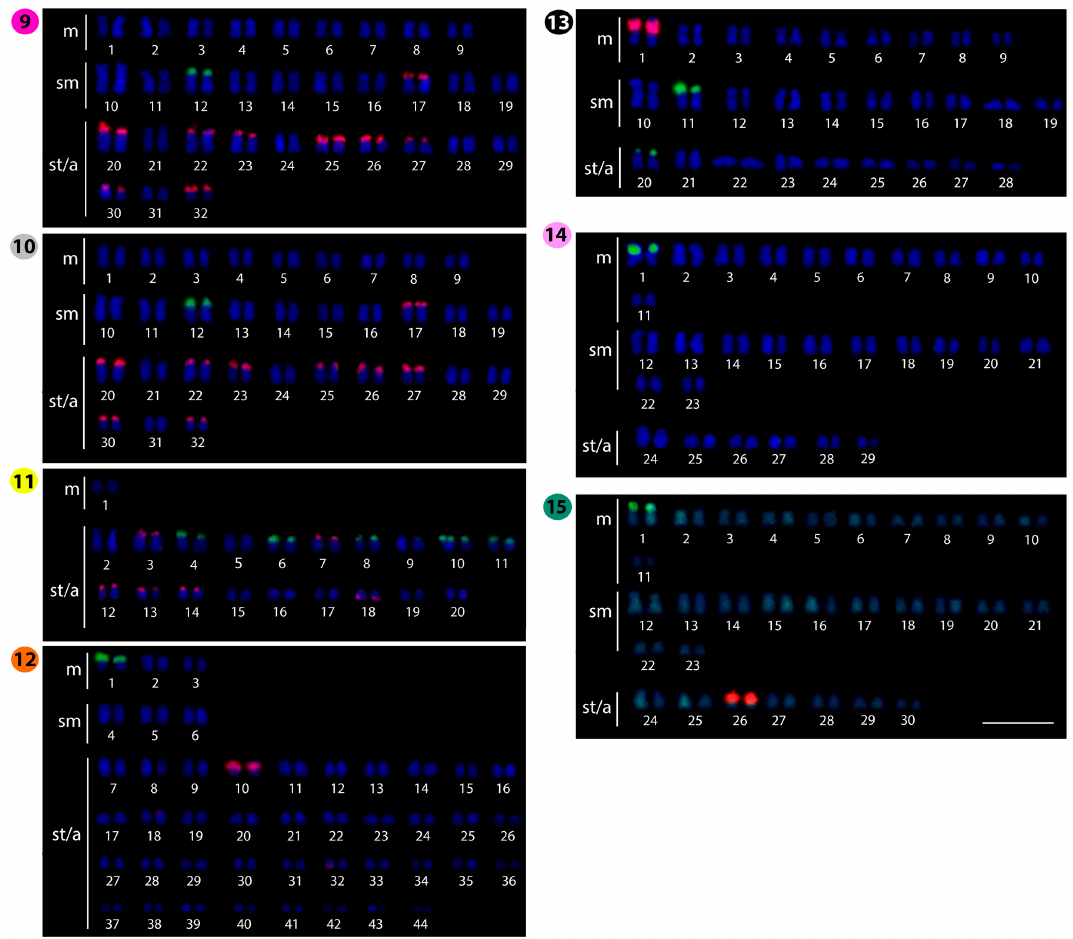
Figure 4. Karyotypes of Phalacronotus apogon ( 9 ); Phalacronotus bleekeri ( 10 ); Silurichthys phaiosoma ( 11 ); Wallago attu ( 12 ); Wallago micropogon ( 13 ); Silurus aristotelis ( 14 ); and Silurus glanis ( 15 ) arranged from chromosomes after double-FISH with 5S rDNA (red) and 18S rDNA (green) probes (except for S. aristotelis , where only 18S rDNA is indicated). Bar = 5 µm.